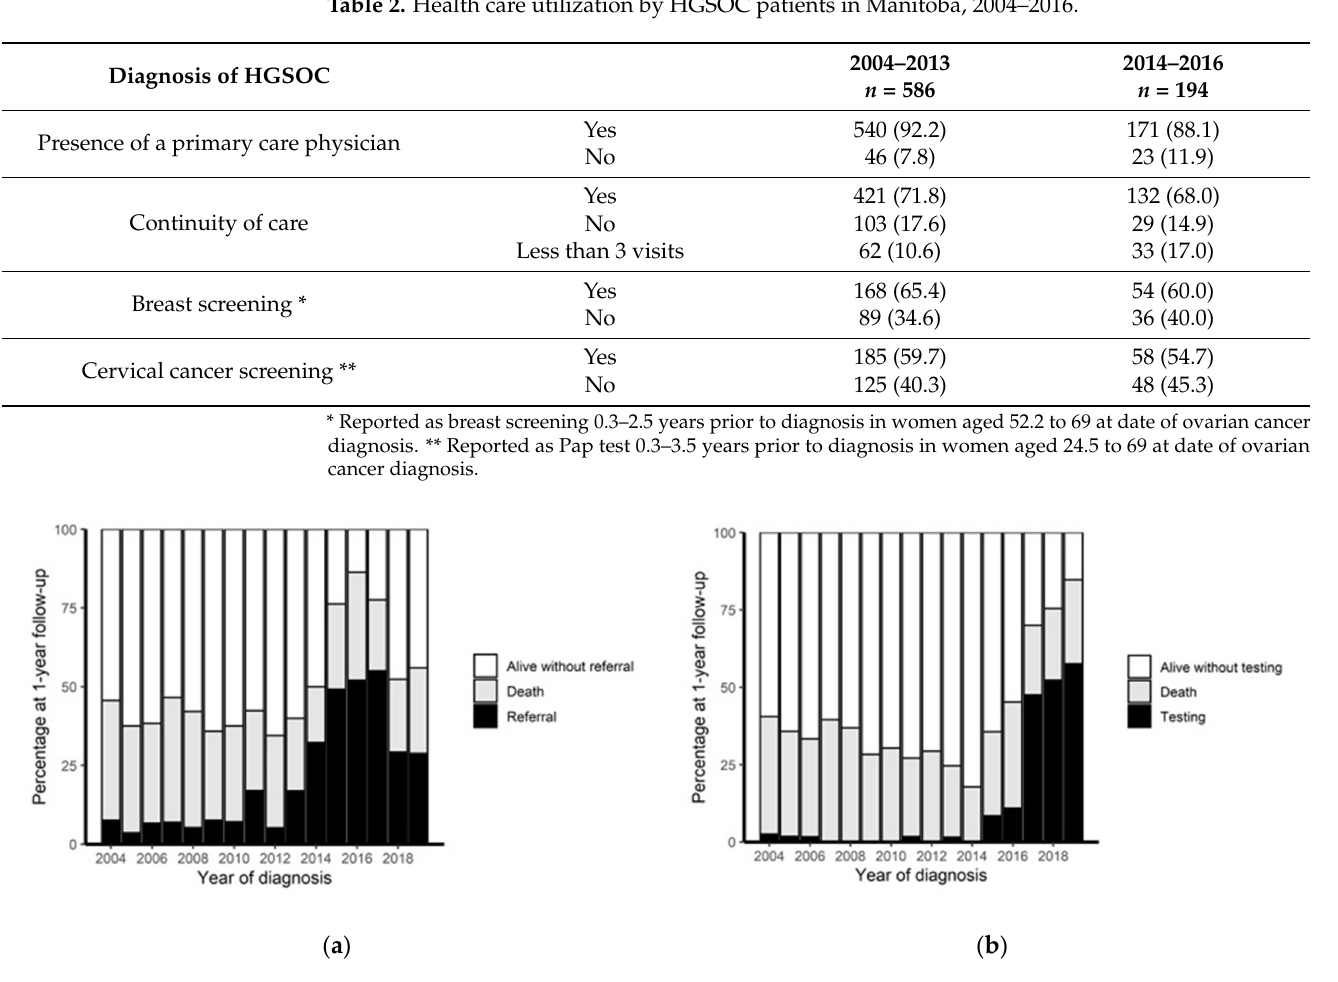
Figure 1. Percentage of genetic consultation at 1 year following diagnosis. Note: in 2014, pathology practice changed to include recommendation for genetics referral on submitted reports; in 2017, practice changed to allow gynecologic oncologist-initiated BRCA testing. ( a ) Percentage of patients with referrals to genetics within 1st year following diagnosis. ( b ) Percentage of patients with genetic results within 1st year following diagnosis. Table 3. Results of genetic testing (2004–2016), n = 114.